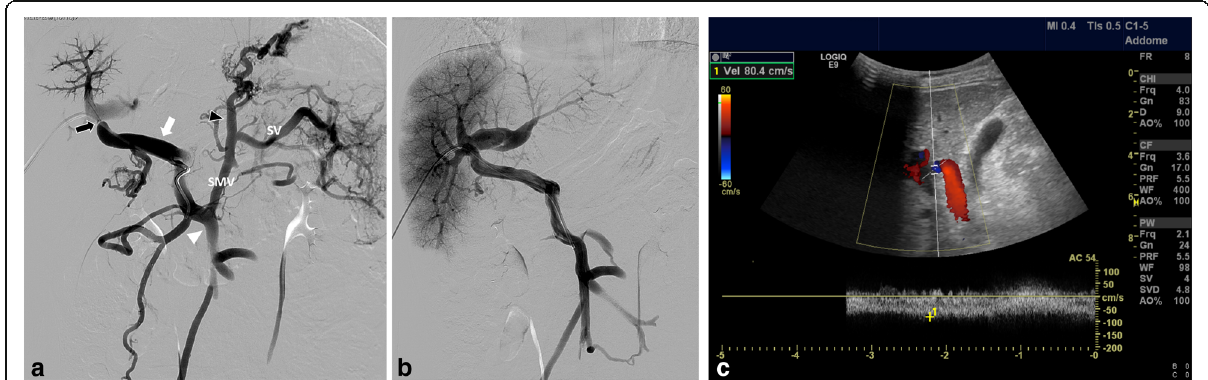
Fig. 2 Images of percutaneous transhepatic portography before and after angioplasty and 1-month follow-up US. a ) Venography of the splanchnic venous system performed after transhepatic catheterization of the venous collateral (white arrow) originating from the mesenteric vein (arrowhead) shows stenotic confluence with the right portal branch (black arrow); the splenic and mesenteric veins present hepatofugal flow and merge into a dilated gastric vein with varices (black arrowhead); no portal vein origin is detectable at its conventional anatomic site. b ) Control venography of the splanchnic venous system performed after angioplasty shows restoration of hepatopetal flow with no opacification of the splenic and gastric veins and varices. c ) After one month the confluence between the mesenteric venous collateral and the right portal branch presents a 5-mm caliber with a flow velocity of 80 cm/s. SMV, superior mesenteric vein; SV, splenic